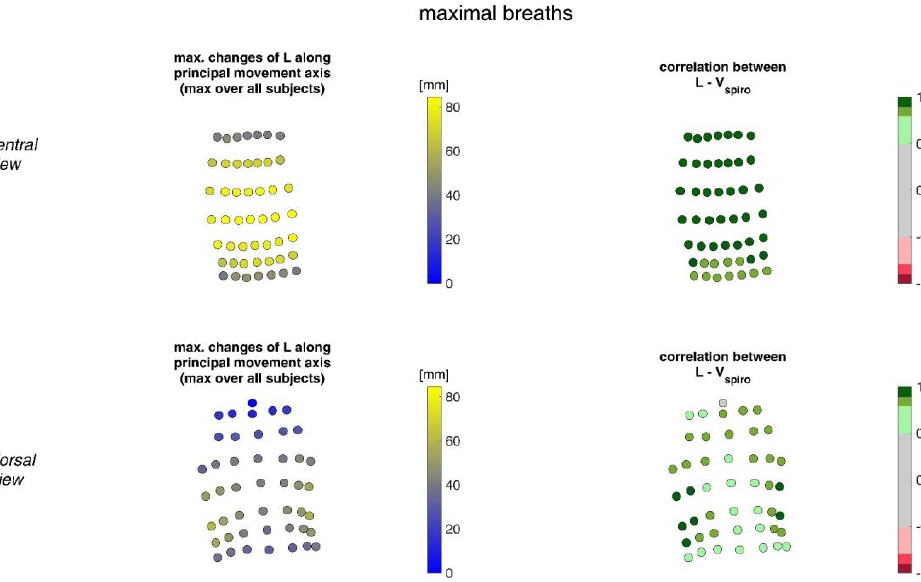
Figure 10. Illustration of the movement of MoCap markers at the upper body along their principal movement axis. The largest movements amongst all subjects during maximal breaths (left) and the mean corresponding correlation of maximal movements with spirometer volume V spiro of all subjects during maximal breaths is shown (right). (Top - ventral view, bottom - dorsal view).